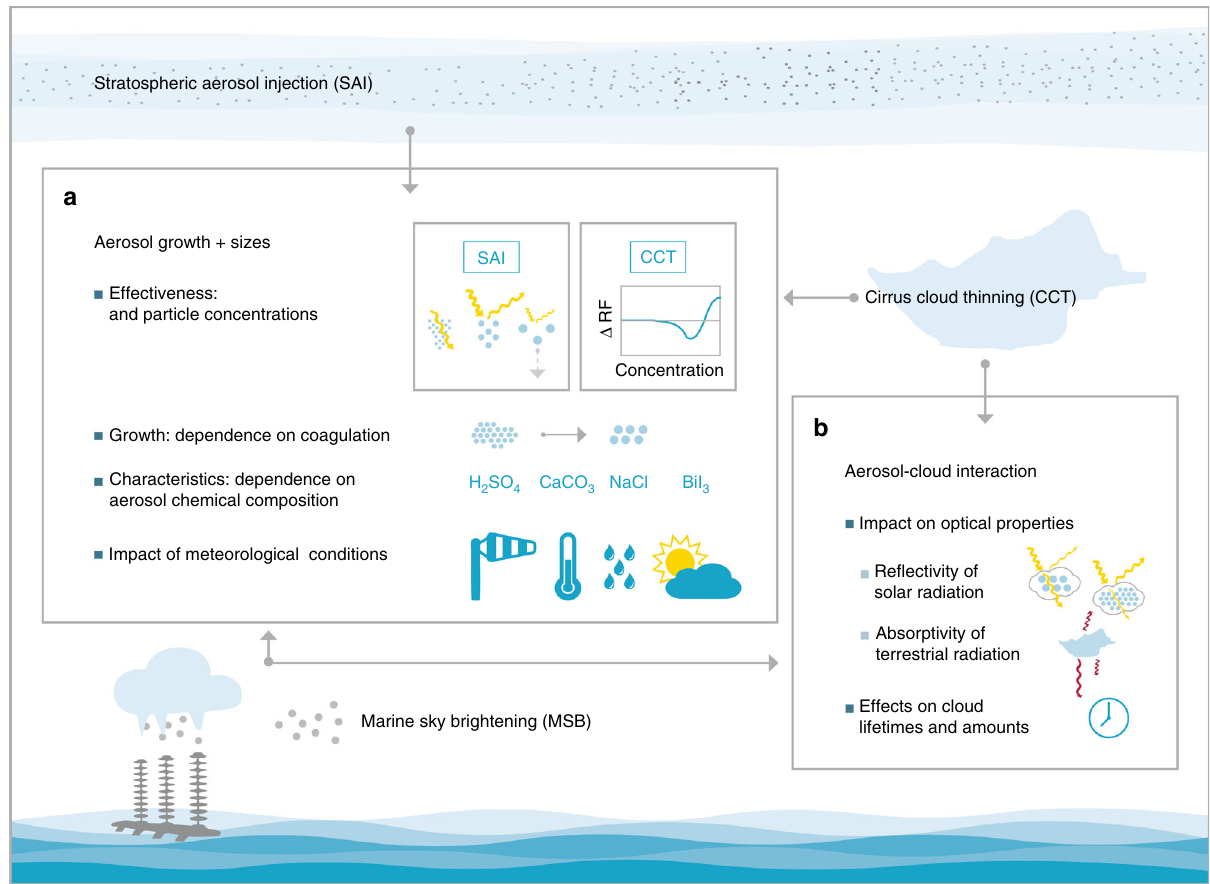
Fig. 5 Key aerosol and cloud microphysics issues involved in atmospheric RFG techniques. For SAI, MSB and CCT, the aerosol and cloud microphysics involved are poorly understood and challenging to simulate – one of the main hindrances to con fi dently predicting the potential climate effects. a The size distribution of the injected or produced aerosol particles in fl uences their effectiveness. As illustrated for SAI, initial studies indicate that there is an optimal particle size (estimated at r ≈ 0.25 μ m 98 ); much smaller particles do not effectively re fl ect sunlight, while much larger particles sediment out too quickly to produce a signi fi cant time-integrated radiative forcing. Simulations indicate that MSB has a smaller optimal particle size ( r ≈ 0.13 μ m), and oversized particles could even lead to a warming instead of cooling 122,157 . CCT is instead mainly affected by the injected particle concentration, with an optimum around 20/l, while excessive concentrations (greater than 100/l) could lead to warming 132 . The size distributions and particle concentrations in turn depend on the particle growth characteristics 98,158,159 , for which coagulation is a particularly important and uncertain factor. Chemical composition